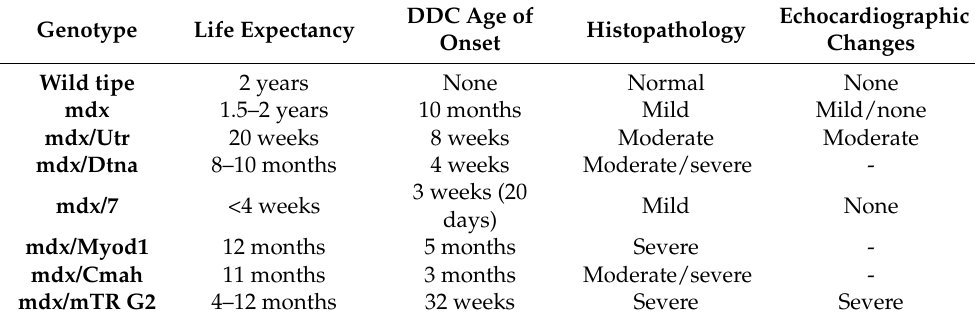
DDC Age of Echocardiographic Histopathology Onset Changes